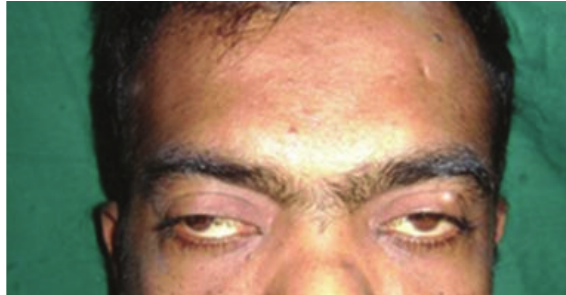
Figure 1: Broad nasal bridge.